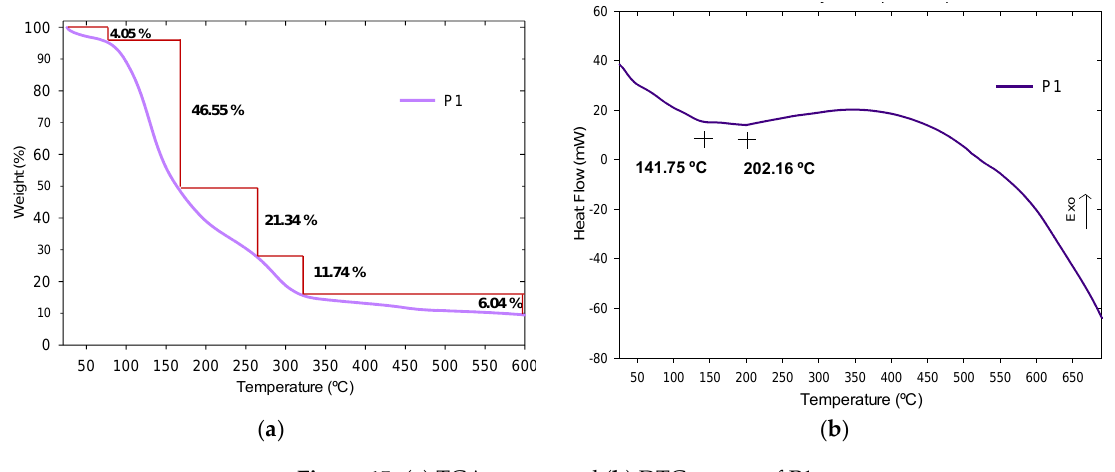
Figure 15. (a) TGA curves and (b) DTG curves of P1. Figure 15. ( a ) TGA curves and ( b ) DTG curves of